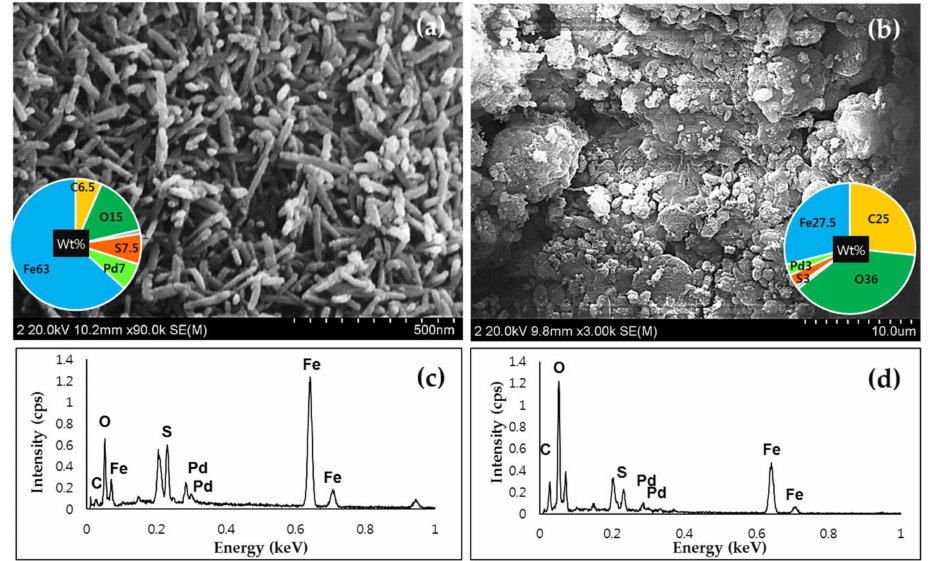
Figure 6. SEM images of ( a ) BPF before reaction with a pie graph indicating elemental weight percentage in relation to ( c ) EDS spectra and ( b ) BC + BPF after reaction with a pie graph indicating elemental weight percentage in relation to ( d ) EDS